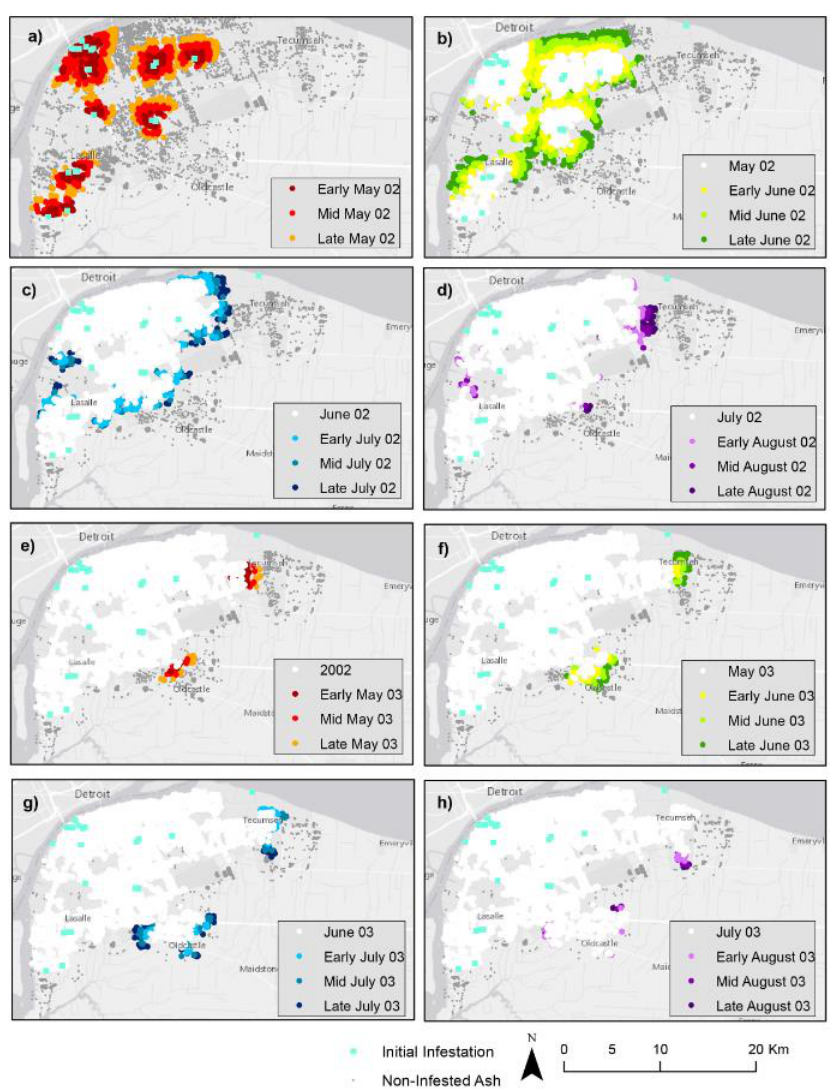
Figure 4. Simulation results of EAB infestation spatial patterns generated for ( a ) May 2002; ( b ) June 2002; ( c ) July 2002; ( d ) August 2002; ( e ) May 2003; ( f ) June 2003; ( g ) July 2003, and ( h ) August 2003 for the Urban Landscape Scenario.